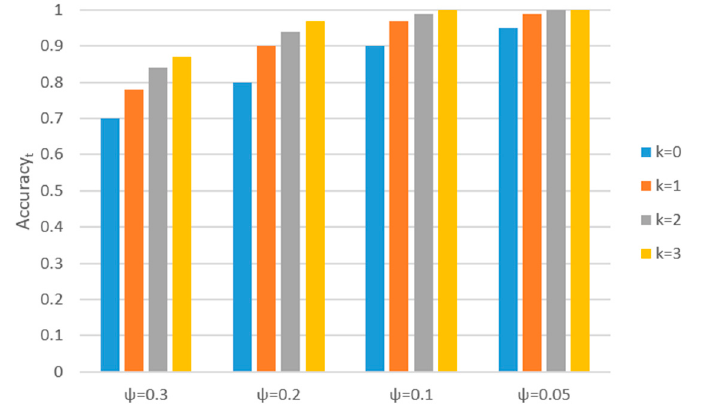
Figure 6. The t Accuracy of different sliding window length k. Figure 6. The Accuracy t of different sliding window length k .